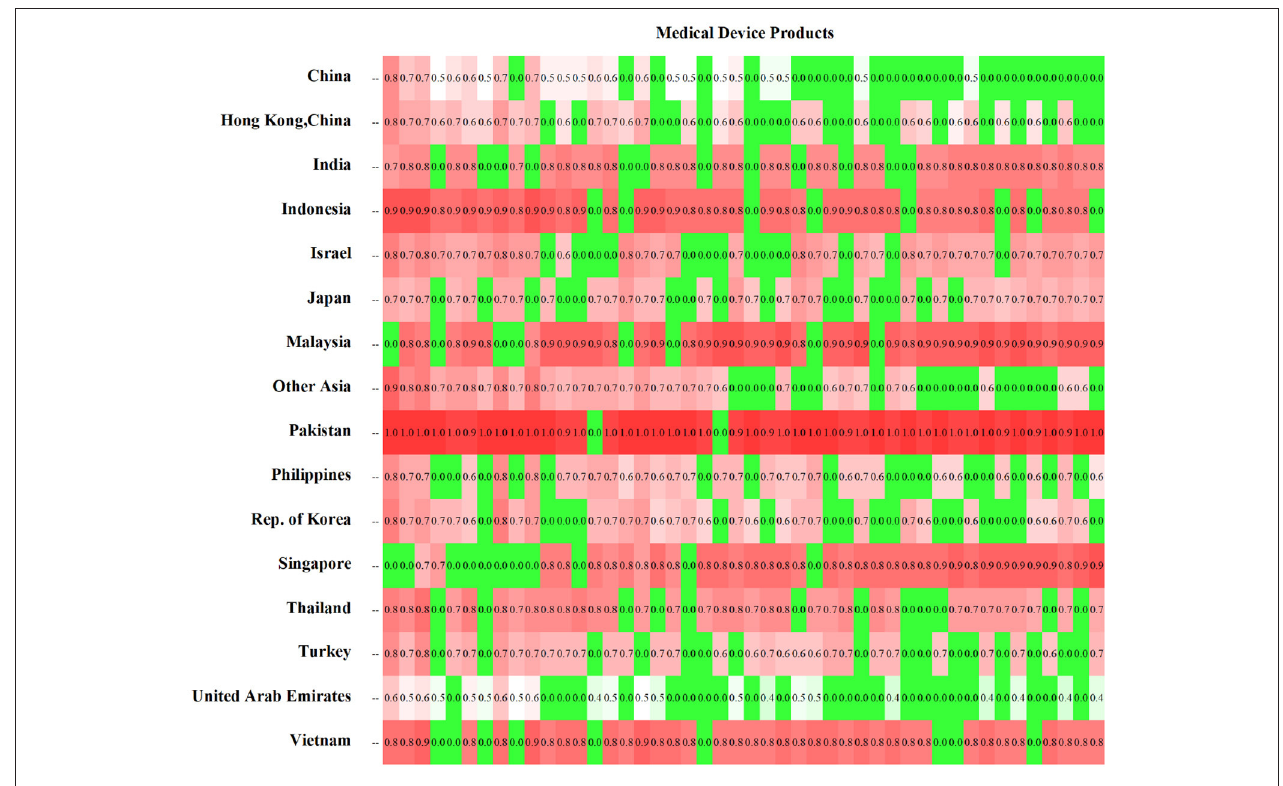
FIGURE 8 | Potential product distance matrix by